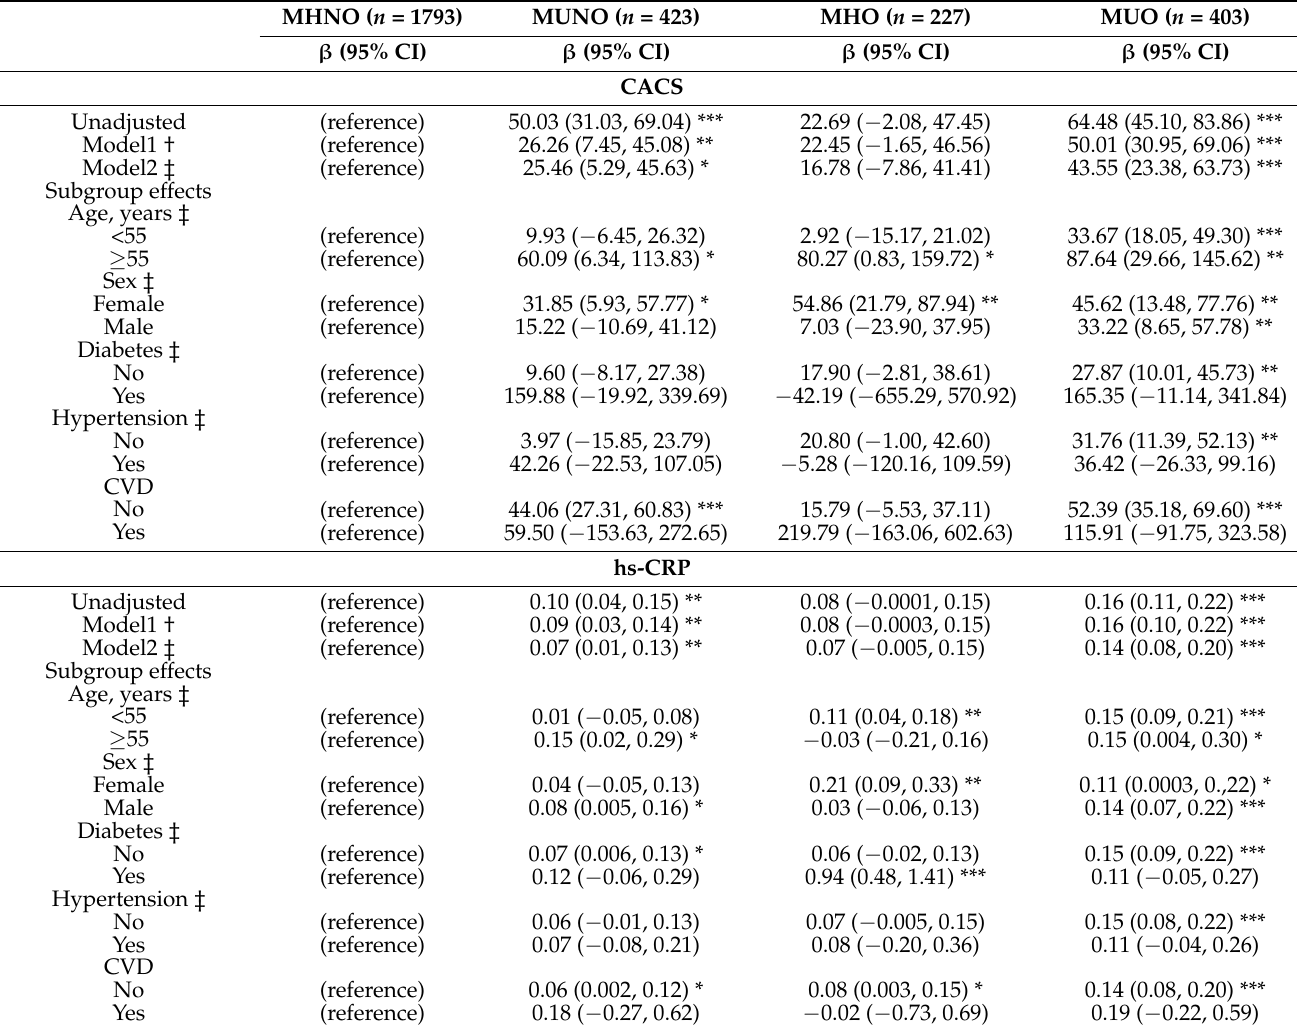
Table 2. Associations between four obesity phenotypes, coronary artery calcification (CAC) burden (according to the CACS), and hs-CRP